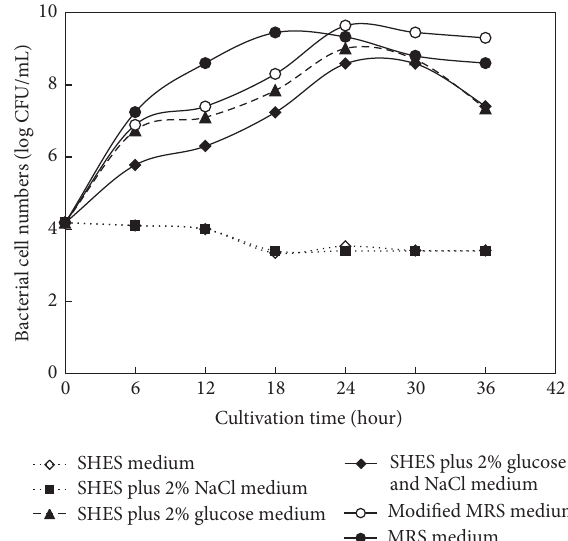
Figure 1: Growth of L. pentosus L7 in six different culture media.